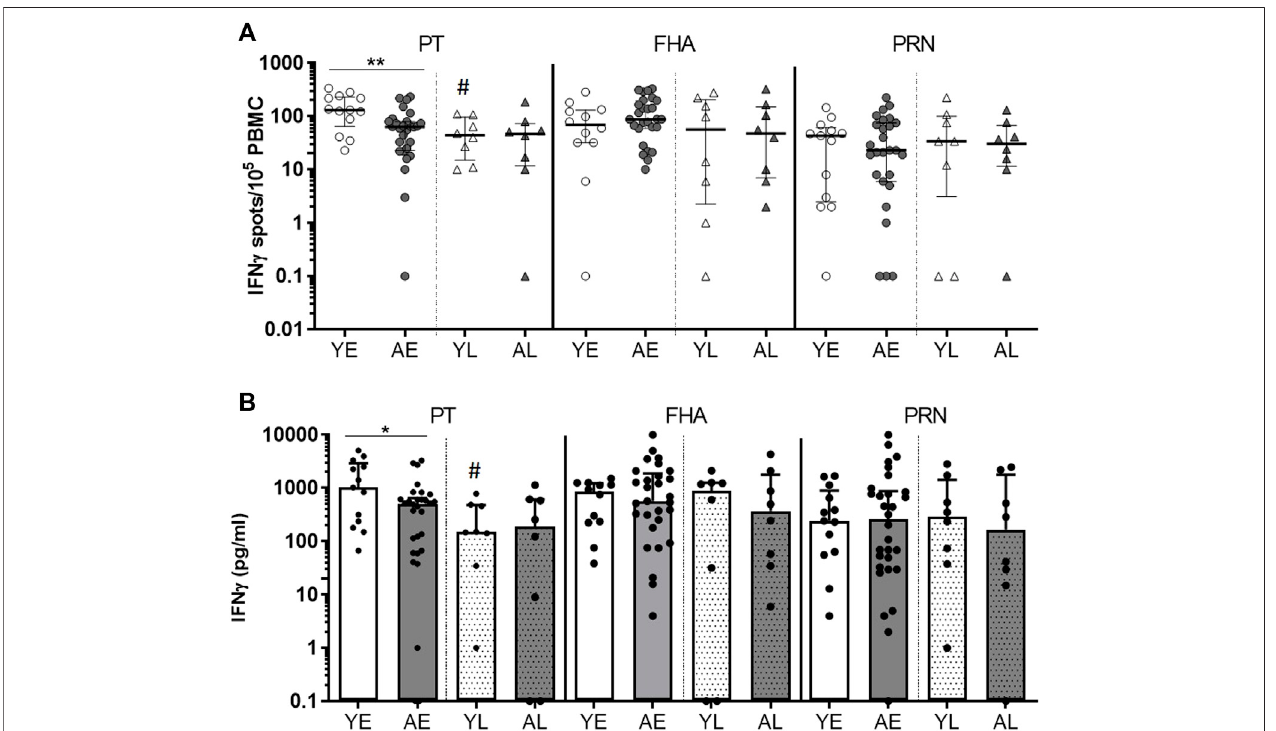
FIGURE1| AdultsshowlowerfrequenciesofPT-speci fi cIFN γ -producingcellsandIFN γ levelsintheearlyphaseafterclinicalpertussis(SKI).PBMCsofyoungsters ( “ Y ” ) and adults ( “ A ” ), from an early timepoint ( ‘ E ’ ; within 4 months after diagnosis), and late timepoint ( “ L ” , 8 – 80 months) after clinical infection were stimulated with Bp proteins PT (left panels) , FHA (middle panels) and PRN (right panels) for 5 days. (A) Numbers of IFN γ -spot forming cells per 10 5 PBMCs measured by ELISpot. (B) IFN γ levels in culture supernatants by Luminex and expressed as [pg/ml]. Symbols show individual cases, while lines and bars indicate medians and interquartile ranges. Statistical signi fi cance was calculated with Mann Whitney U -test. * p < 0.05, ** p < 0.01; # (cid:1) signi fi cantly lower compared to the early phase.